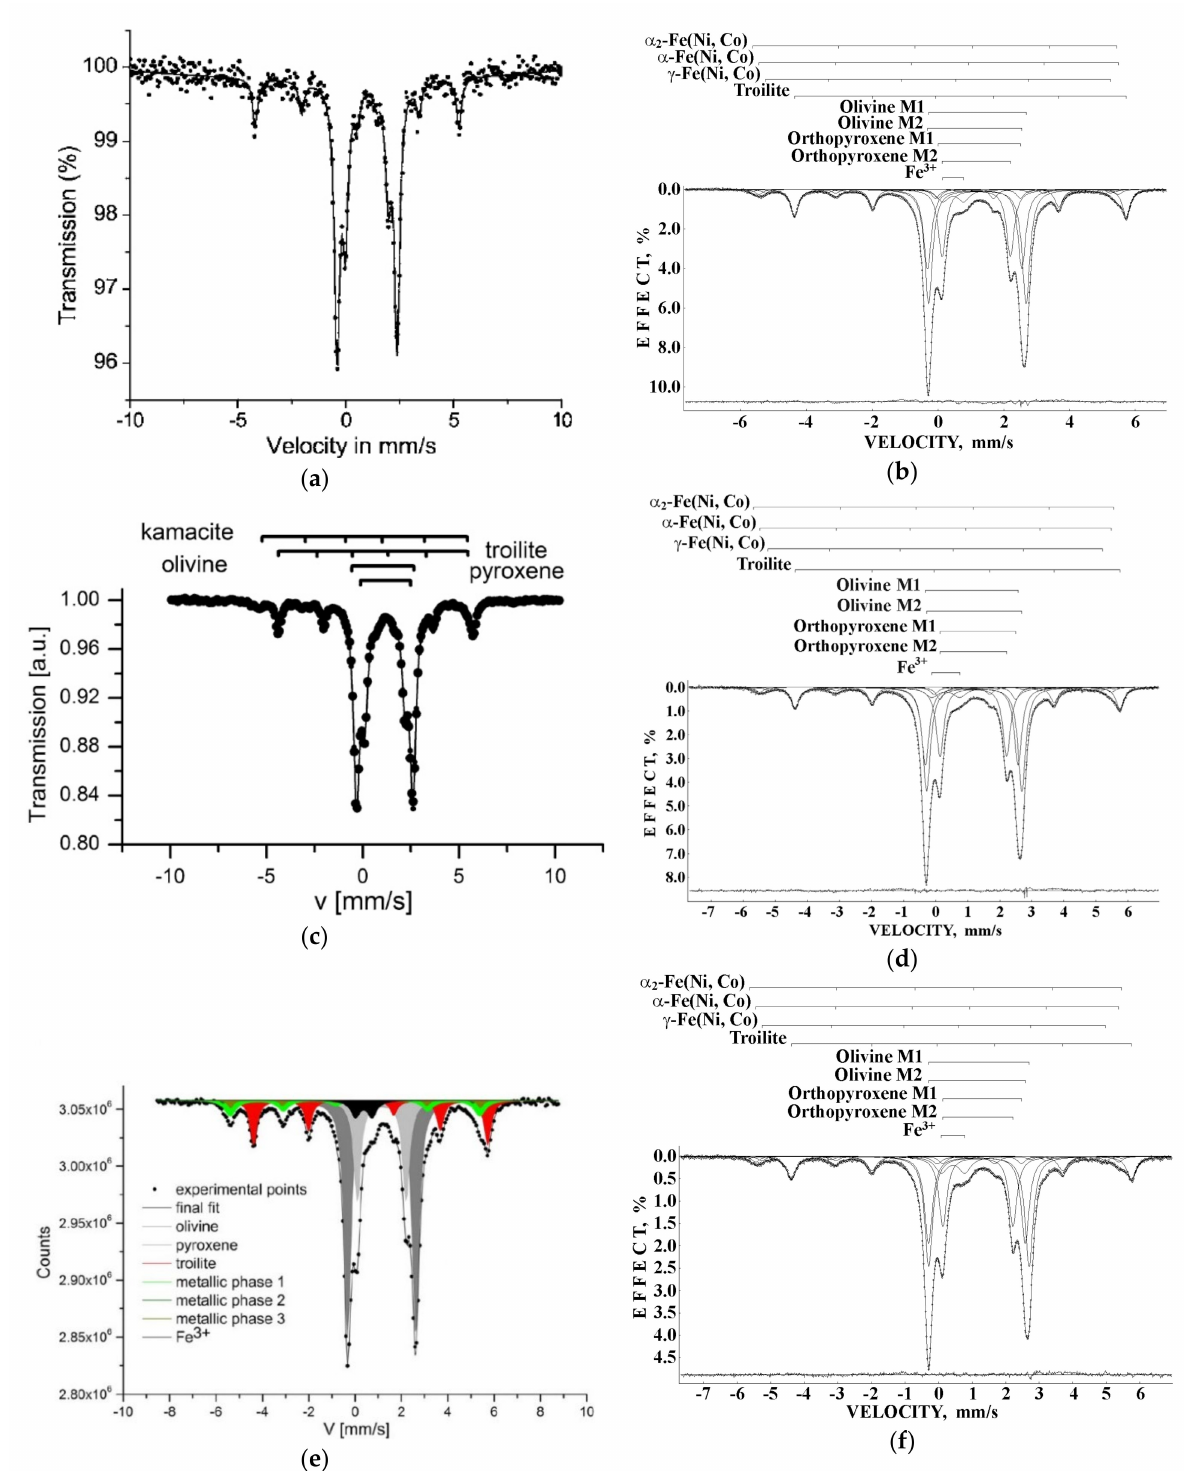
Figure 26. Comparison of the room temperature Mössbauer spectra of equilibrated ordinary chondrites Mbale L5/6 ( a , b ), Mount Tazerzait L5 ( c , d ) and Saratov L4 ( e , f ) measured with a low velocity resolution ( a , c , e ) and with a high velocity resolution ( b , d , f ). Indicated components are the results of the fits. The differential spectra are shown on the bottom ( b , d , f ). Adapted from References